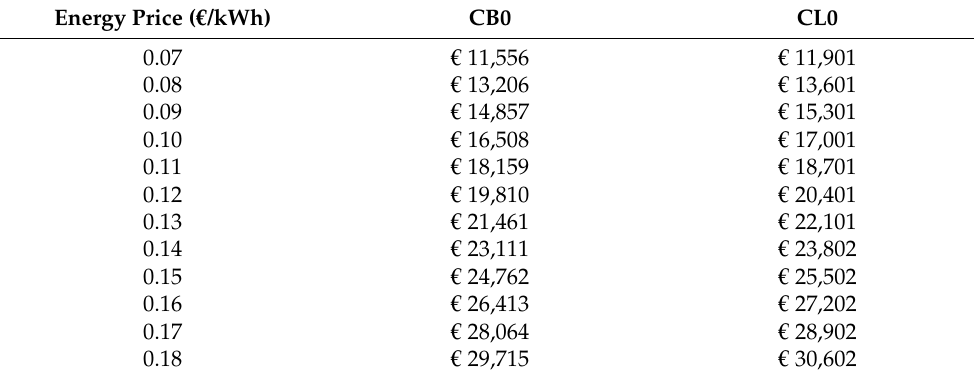
Table 8. Energy price per kWh and corresponding energy savings in Euro for CB0 and CL0.